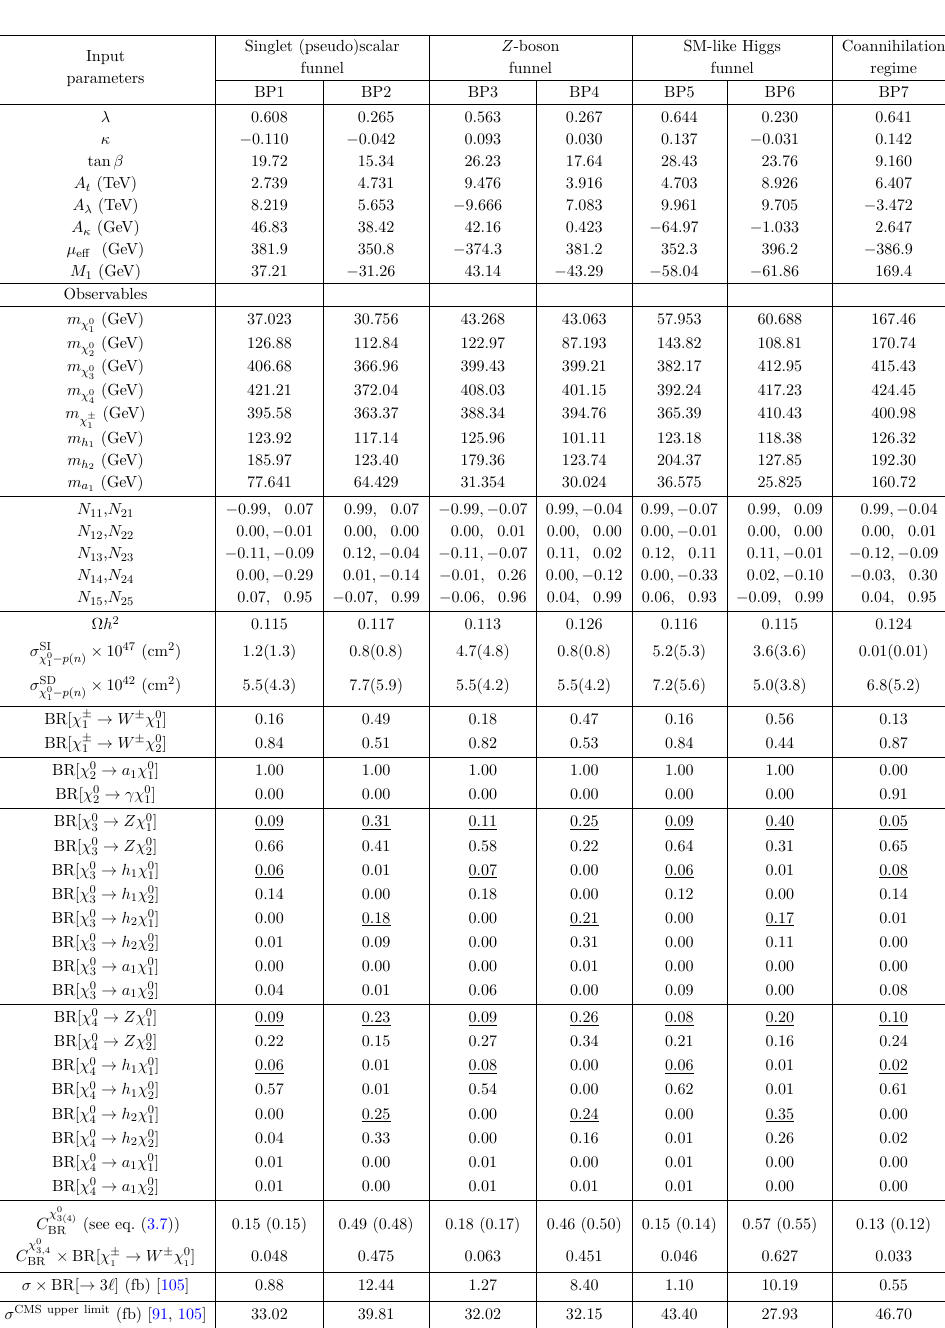
Table 3 . Benchmark points (BPs) allowed by relevant theoretical and experimental constraints including those from the LEP, the low-energy sector and the studies on the SM-like Higgs boson at the LHC. Shown are the masses of the various relevant states, the compositions of the LSP and the NLSP ( N ’s). Relevant individual and combined branching ratios involving the ewinos are also ij presented. The last two rows show the theoretical expectation of the yields in the trilepton final state and the LHC (CMS) upper limit on the same (figures 7 and 8a of [91]), respectively. Fixed parameters are as presented in table 1. All BPs assume a decoupled wino ( M m A and m H range over a few